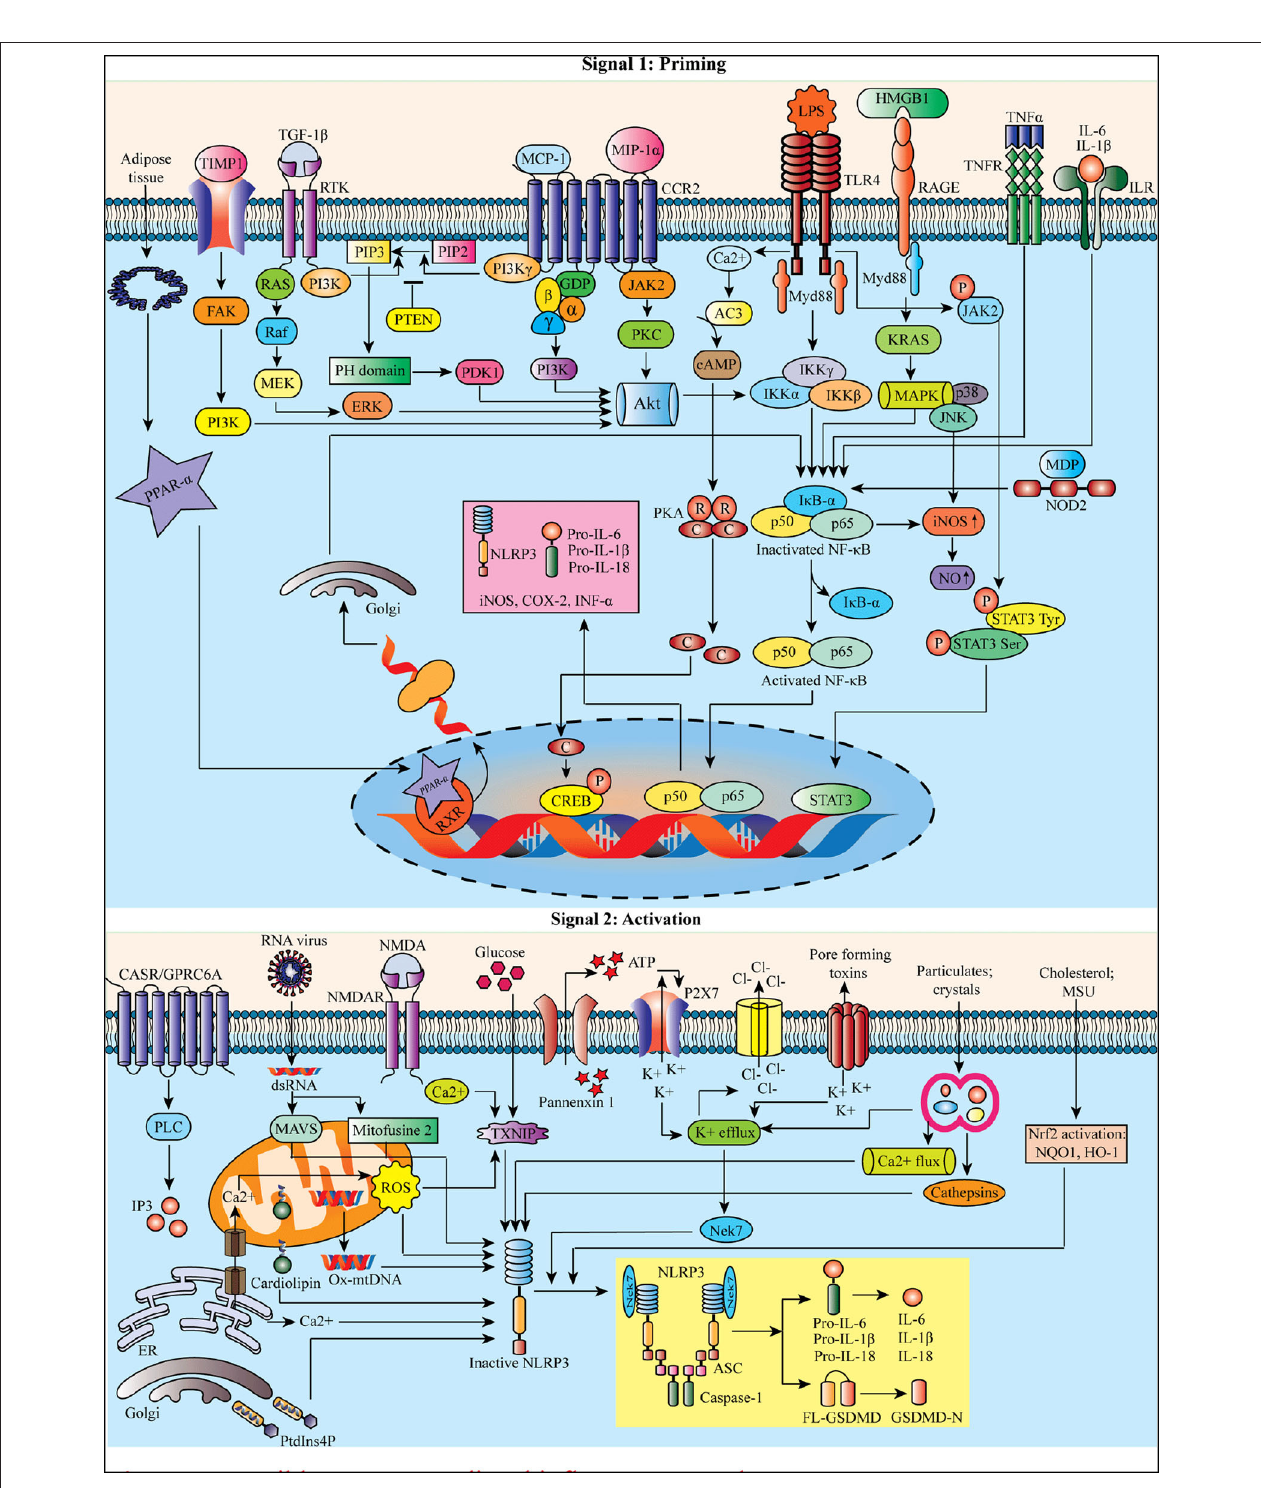
FIGURE 1 | Possible NLRP3-mediated inflammatory pathways.